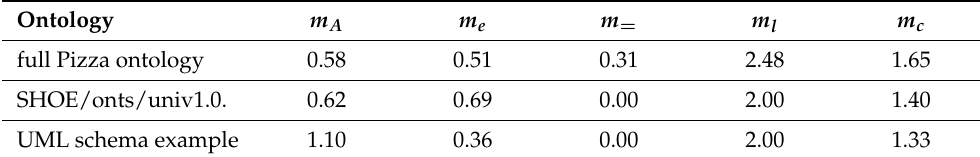
Figure 4. Ontology metrics diagram. Table 6. Ontology